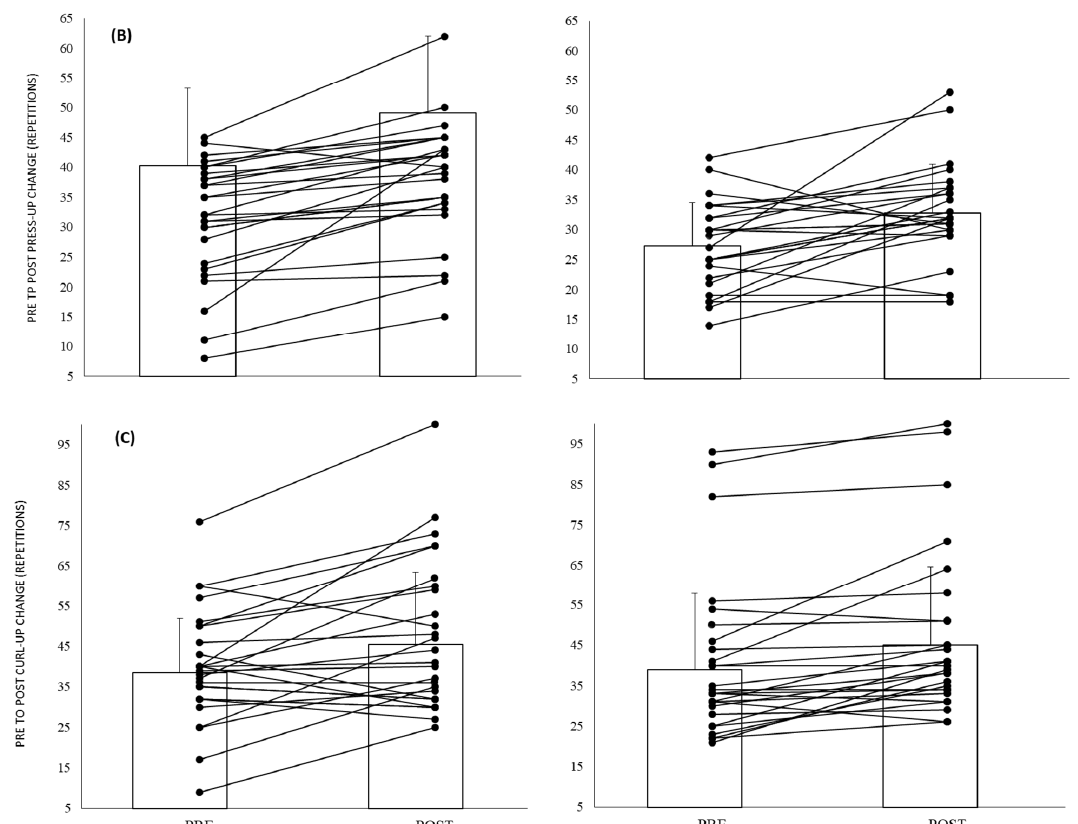
Figure 1. Pre to post performance change for compression garments (CG) and control (CON) groups over the 6 weeks of military training. Boxed columns indicate mean and SD, and lines indicate individual participant results. ( A ) 2.4 km run (s), ( B ) press-ups (repetitions), ( C ) curl-ups (repetitions).